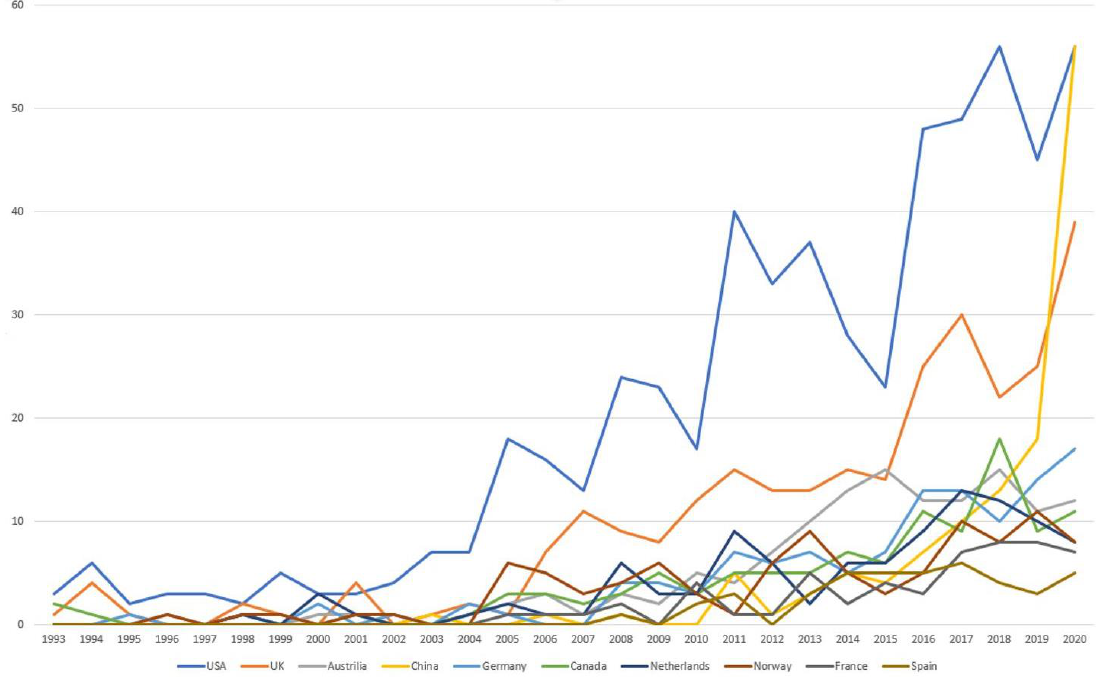
Figure 5. Annual trends in publications from top 10 countries.